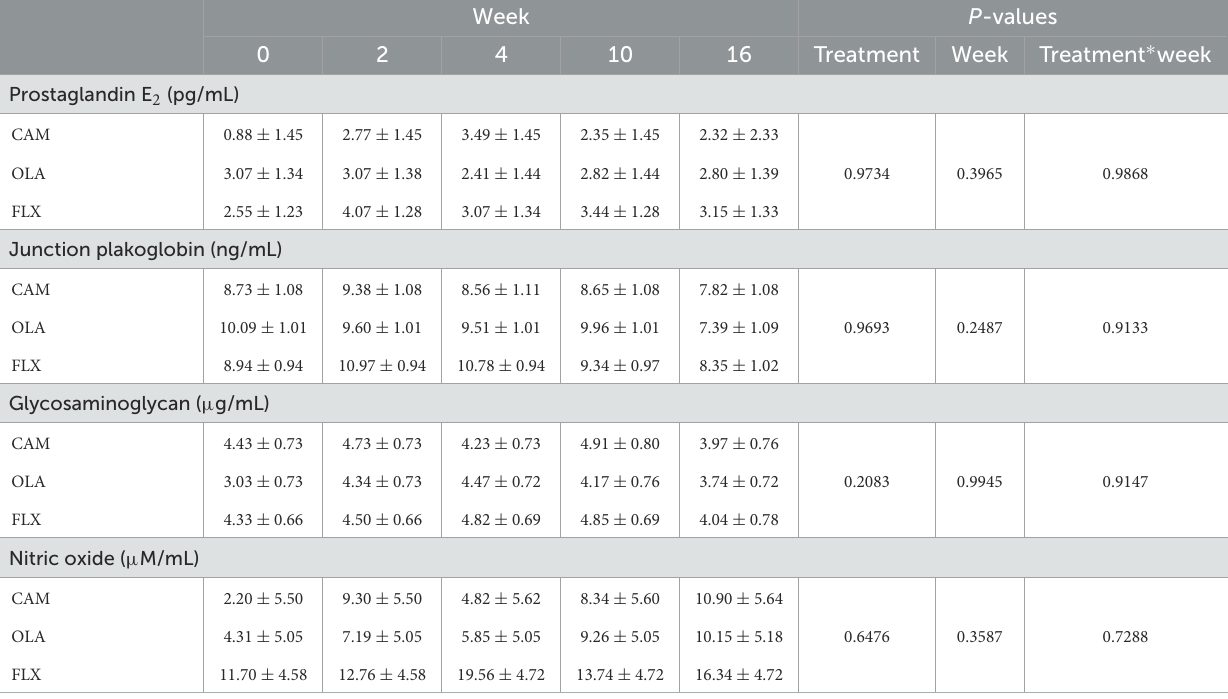
TABLE 4 Serum prostaglandin E 2 , junction plakoglobin, glycosaminoglycan, and nitric oxide concentrations of healthy adult dogs supplemented one of three treatment oils a on weeks 0, 2, 4, 10, and 16 of a skin and coat health trial, presented as lsmeans ± standard error. Week P -values